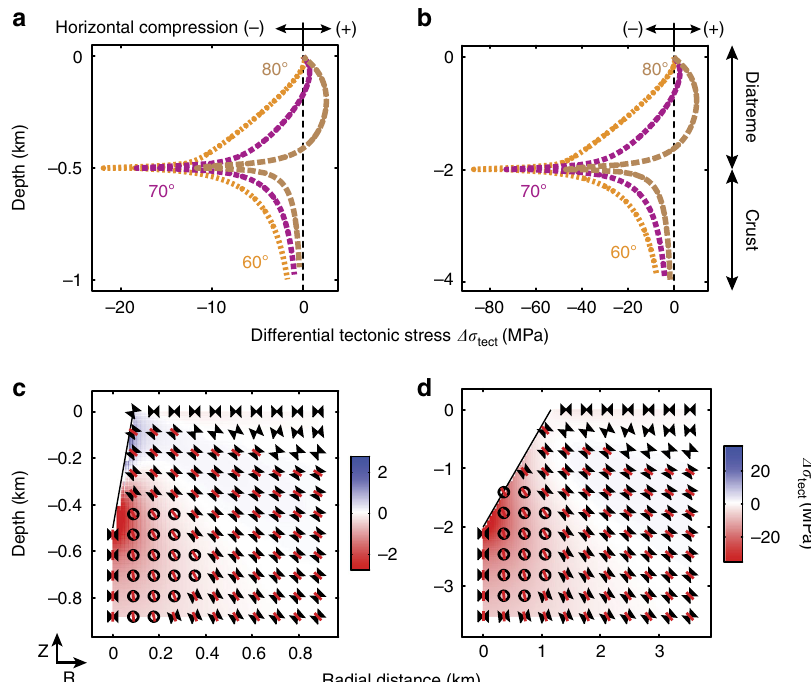
Fig. 2 State of stress within the crust surrounding the newly formed diatreme. a , b Differential tectonic stress along the diatreme fl ank and in the underlying crust for different wall dips ( α = 80, 70, and 60°, in brown, purple, and orange-colored thick-dashed lines, respectively) and for different diatreme depths D = 500 m ( a ), D = 2000 m ( b ). Separated by a dash line, positive and negative values correspond to horizontal extensional and compressional stresses, d d respectively. c , d Differential tectonic stress and stress orientation within the crust for different diatreme geometries, D d = 500 m, α = 80° ( c ); D d = 2000 m, α = 60° ( d ). Blue and red shadings represent extensional and compressional Δσ tect , respectively. Based on Melosh and Williams 34 and McGovern and Solomon 35 , the hourglass shapes are oriented along the direction of greatest compressive stress ( σ 1 ); the red bars along the direction of least compressive stress ( σ 3 ). Circles represent out-of-the plane hourglass shapes ( σ 1 perpendicular to the r – z